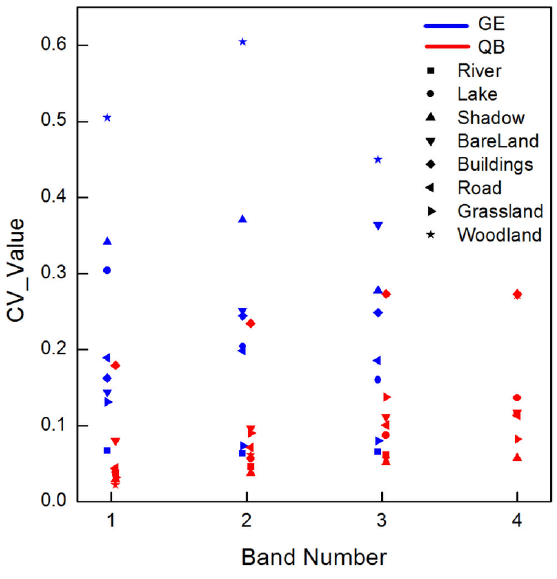
Figure 3. Comparison of the coefficient of variation (CV) between GE and QB image for major land cover